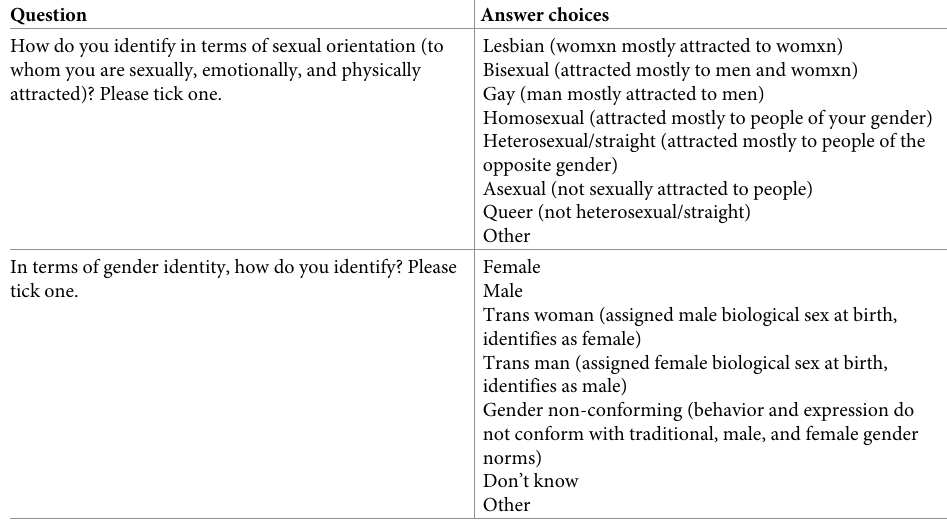
Table 2. Sexual orientation and gender identity survey